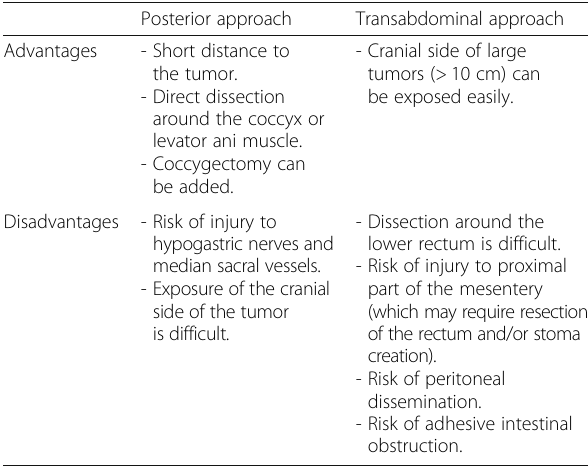
Table 1 Advantages and disadvantages of each approach for presacral tumor resection Posterior